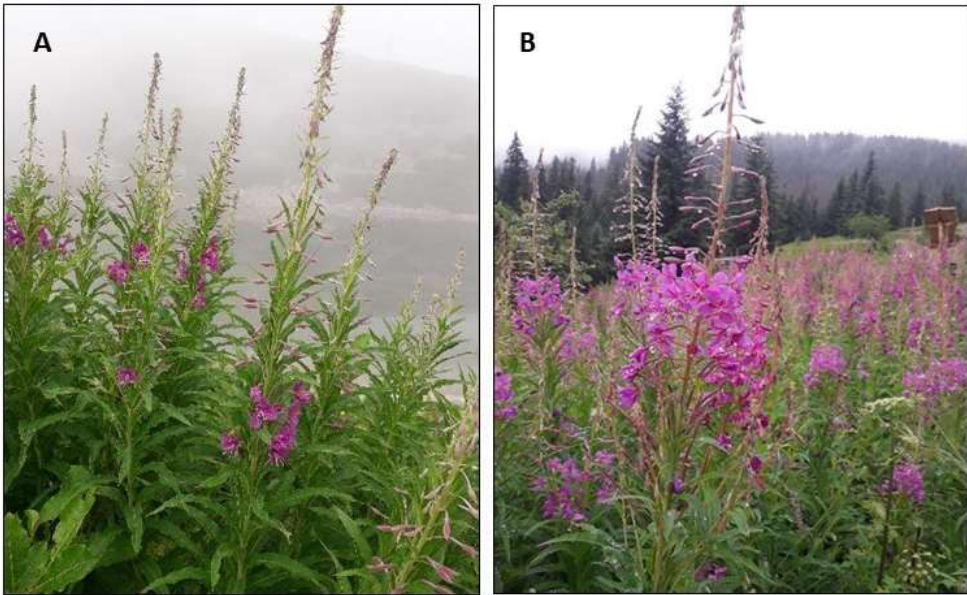
Figure 1. Epilobium angustifolium in a natural location in the Carpathians. ( A )—Slovak Tatras, 1751 m a.s.l.; ( B )—Polish Tatras, 1333 m a.s.l.